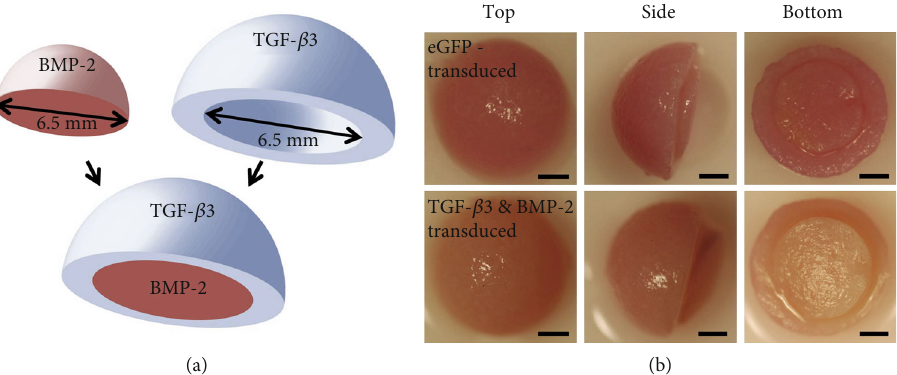
Figure 4: Osteochondral constructs. (a) Schematic diagram of fusing concentric hemispheres with embedded lentivirus of TGF- β 3 and BMP- 2. (b) Pictures of eGFP-transduced or TGF- β 3+BMP-2-transduced constructs from 3 di ff erent angles. Scale: 2 mm. Reproduced with permission